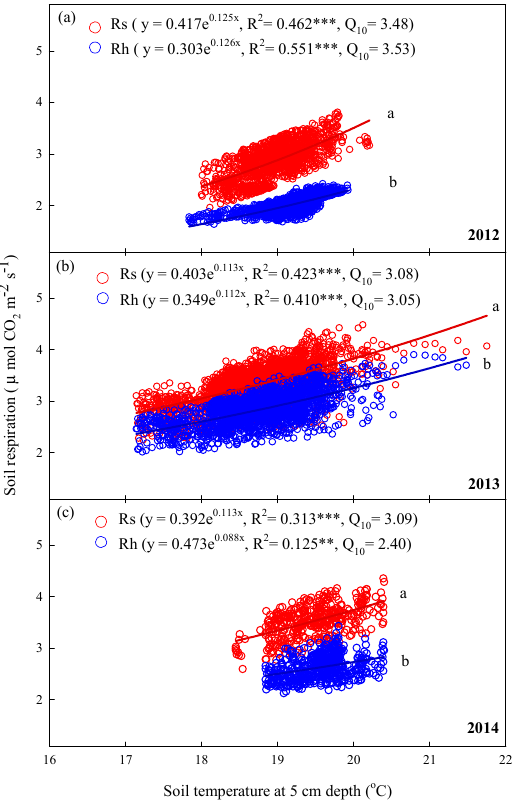
Figure 7. Relationships between hourly mean soil respiration (Rs, μ mol CO 2 m − 2 s − 1 ) and hetero- trophic respiration (Rh) and half-hourly soil temperature at 5 cm depth (°C) in summer (June– August) in ( a ) 2012, ( b ) 2013, and ( c ) 2014. Asterisks indicate significance: *** p < 0.001; ** p < 0.01. Different letters indicate differences between regression lines within the same year at p < 0.05.